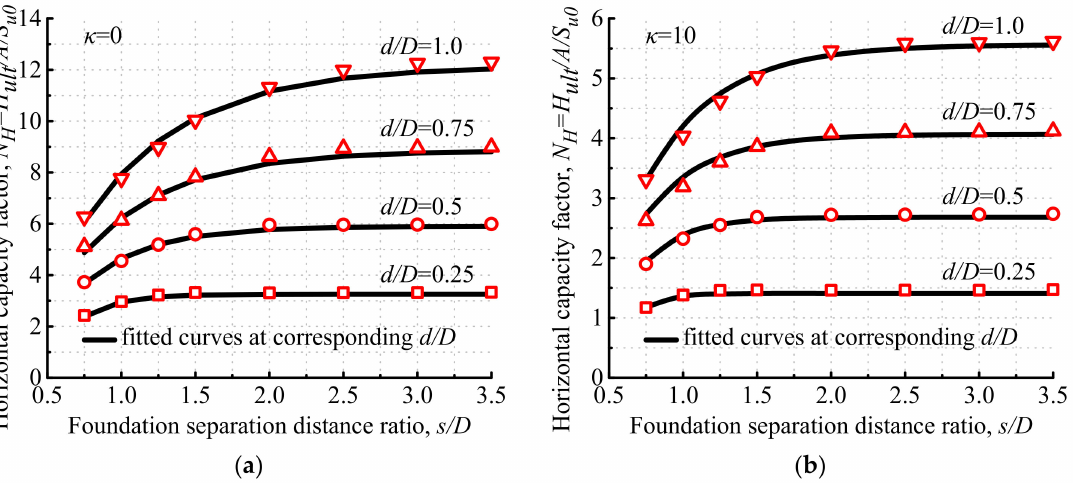
Figure 14. Comparisons of horizontal capacity factors for tetrapod bucket foundations between finite-element results and fitted curves when ( a ) κ = 0 and ( b ) κ =